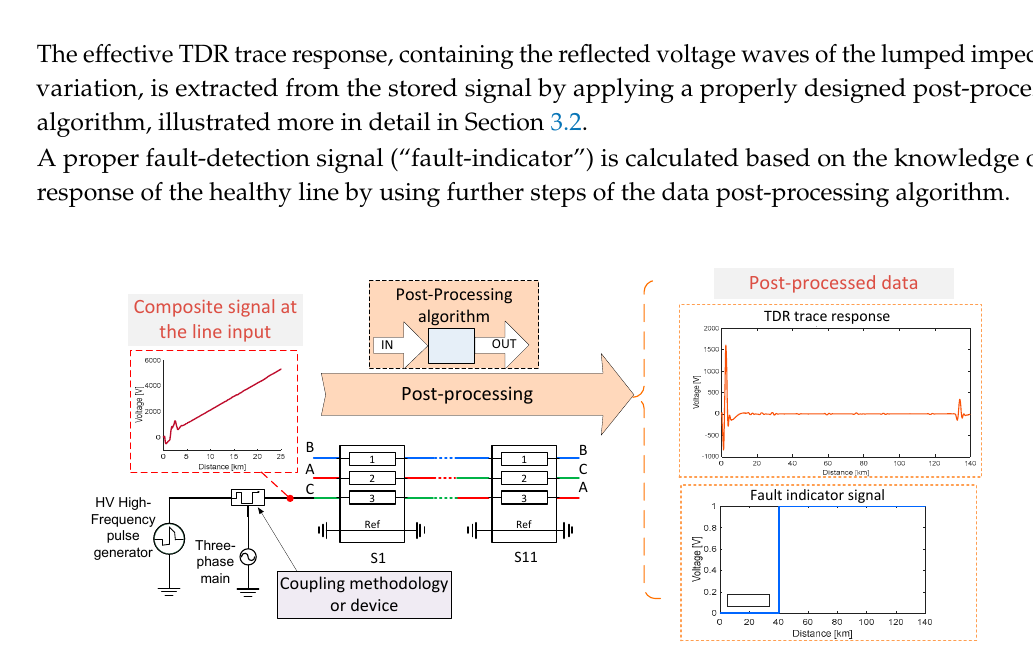
Figure 5. Schematic illustration of the overall proposed TDR-like fault-detection strategy suitable for in-service lines.